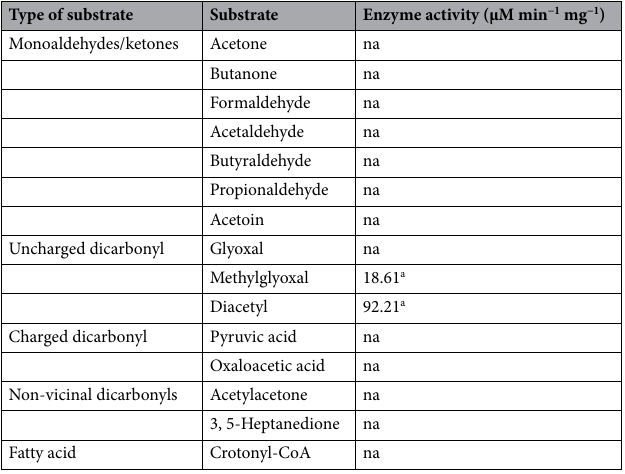
Table 2. Substrates used in screening for reduction reaction of BPSS2242. The reaction mixture contained 20 mM sodium phosphate (pH 6.5), 200 µM NAD(P)H and various concentrations of substrate (0.1–20 mM). na no activity. a NADPH was used as a